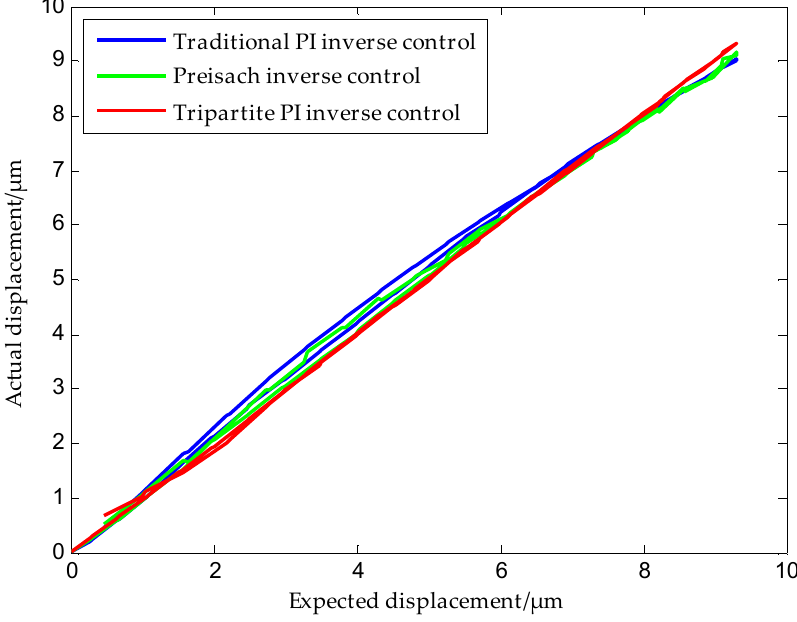
Figure 20. Comparison of the positioning accuracies of different models.